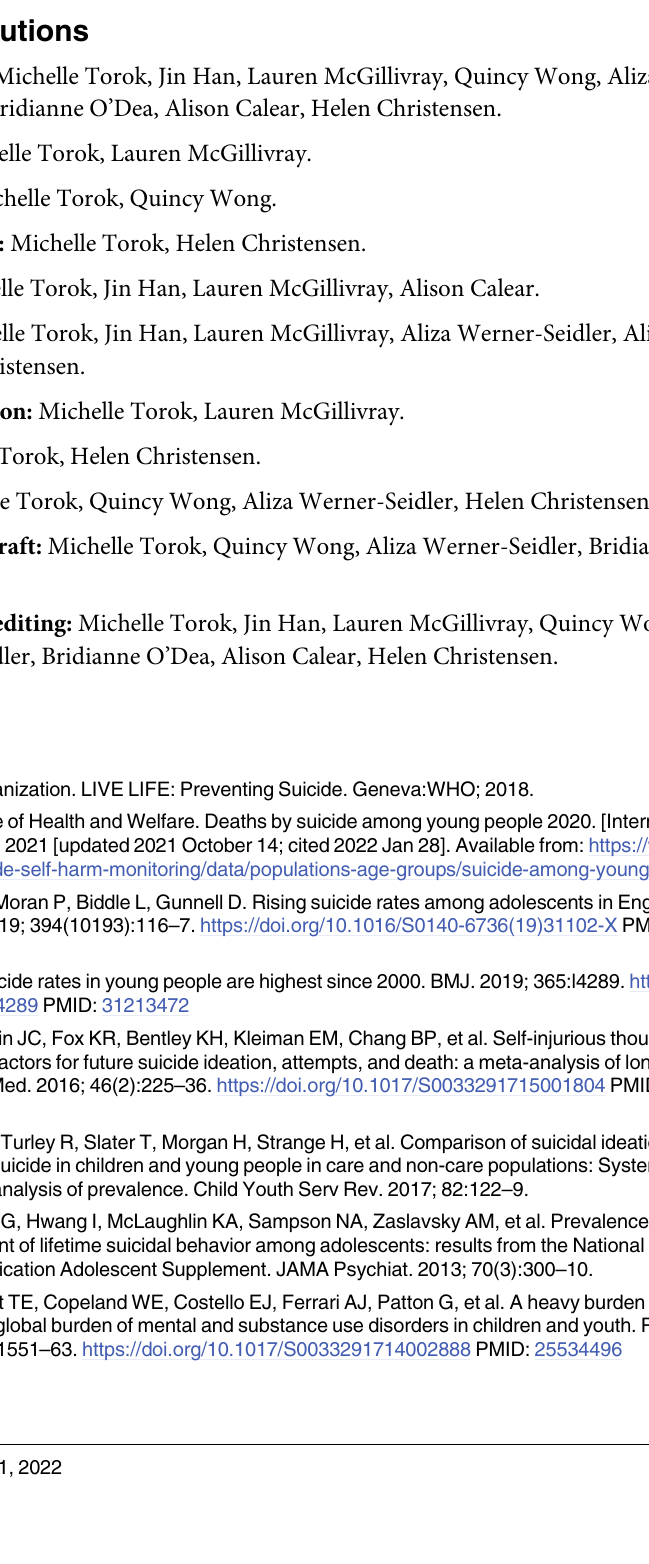
S1 Table. Baseline characteristics of the sample for those who did or did not complete